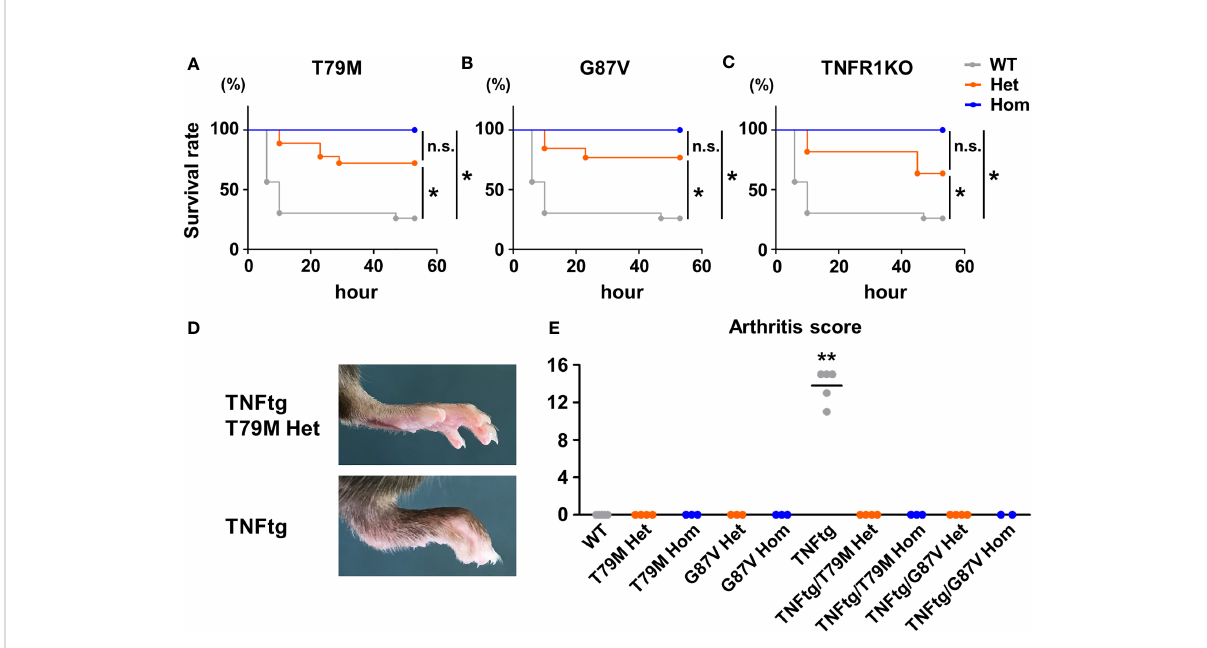
FIGURE 2 TRAPS mutations strongly suppressed lethal response by LPS and D-galactosamine and diminished TNF a -mediated arthritis. (A-C) T79M and G87V TRAPS mutant mice and TNFR1 KO mice were intraperitoneally administrated with LPS (100 m g/kg body weight) and D-galactosamine (400 mg/kg body weight). Survival rates of the mice after the administration of LPS and D-galactosamine. Survival rates of WT ( n = 23), T79M strain (A) ; Het ( n =18), Hom ( n = 9), G87V strain (B) ; Het ( n =13), Hom ( n = 13), and TNFR1 KO strain (C) ; Het ( n =11), Hom ( n = 9). Gray, orange, and blue lines indicate WT, heterozygotes, and homozygotes, respectively. p -values for the differences between subgroups of mice were calculated by log-rank test using strati fi ed analysis. (D, E) T79M or G87V mutant mice were crossed with TNFtg mice, and the severity of arthritis was evaluated. WT ( n = 5), T79M Het ( n = 4), T79M Hom ( n = 3), G87V Het ( n = 3), G87V Hom ( n = 3), TNFtg ( n = 5), TNFtg/T79M Het ( n = 4), TNFtg/T79M Hom ( n = 3), TNFtg/G87V Het ( n = 4), TNFtg/G87V Hom ( n = 2). (D) Representative images of the hind paw of TNFtg T79M heterozygous mouse and TNFtg mouse. (E) Arthritis scores of the mice at the age of 17 weeks. ** p <0.01 vs . any other groups. WT, wild-type; TNFtg, TNF a transgenic; TNF a , Tumor necrosis factor a ; TRAPS, TNF receptor-associated periodic syndrome; IL, interleukin; LPS, lipopolysaccharide; TNFR1, TNF receptor type I; TNFtg, Human TNF a -transgenic mice; Het, heterozygote; Hom, homozygote. * p <0.01; n.s., not signi fi